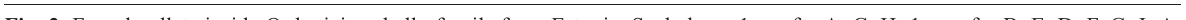
Fig. 3. Faecal pellets inside Ordovician shelly fossils from Estonia. Scale bars: 1 cm for A, C, H; 1 mm for B, E, D, F, G, I. A , echinoderm Sphaeronites , massive accumulation of pellets, vertical section, GIT 156­1066, Värska 6 drill core, 381.8 m, Haljala Stage, Sandbian. B , detail of GIT 156­1066, C. oblongus . C , brachiopod Porambonites , two sets of pellets inside, boundary between sets is distinct, one of the sets is almost completely decomposed, GIT 399­1961, Aluvere quarry, Haljala Stage, Sandbian. D , detail of GIT 399­1961, C. oblongus . E , gastropod Hormotoma insignis , surface of steinkern, two different sizes of Coprulus (L/W ratio 2.7), TUG 80­484, Piilse, Rakvere Stage, Katian. F , bivalve Aristerella , detail of surface, Coprulus (L/W ratio 4), GIT 694­93, Kullaaru ditch, Oandu Stage, Katian. G , gastropod Subulites wesenbergensis , horizontal section through the apical part of steinkern, boundary between the accumulation of pellets and sediment is transitional, decomposition of pellets is almost finished, GIT 404­639, Mõnuste quarry Harjumaa, Vormsi Stage, Katian. H , gastropod Lesueurilla, horizontal section through the apical part, Coprulus (L/W ratio 2.3), GIT 720­1, Aluvere quarry, Haljala Stage, Sandbian. I , detail of GIT 720­1, on the left side of the image are decomposed